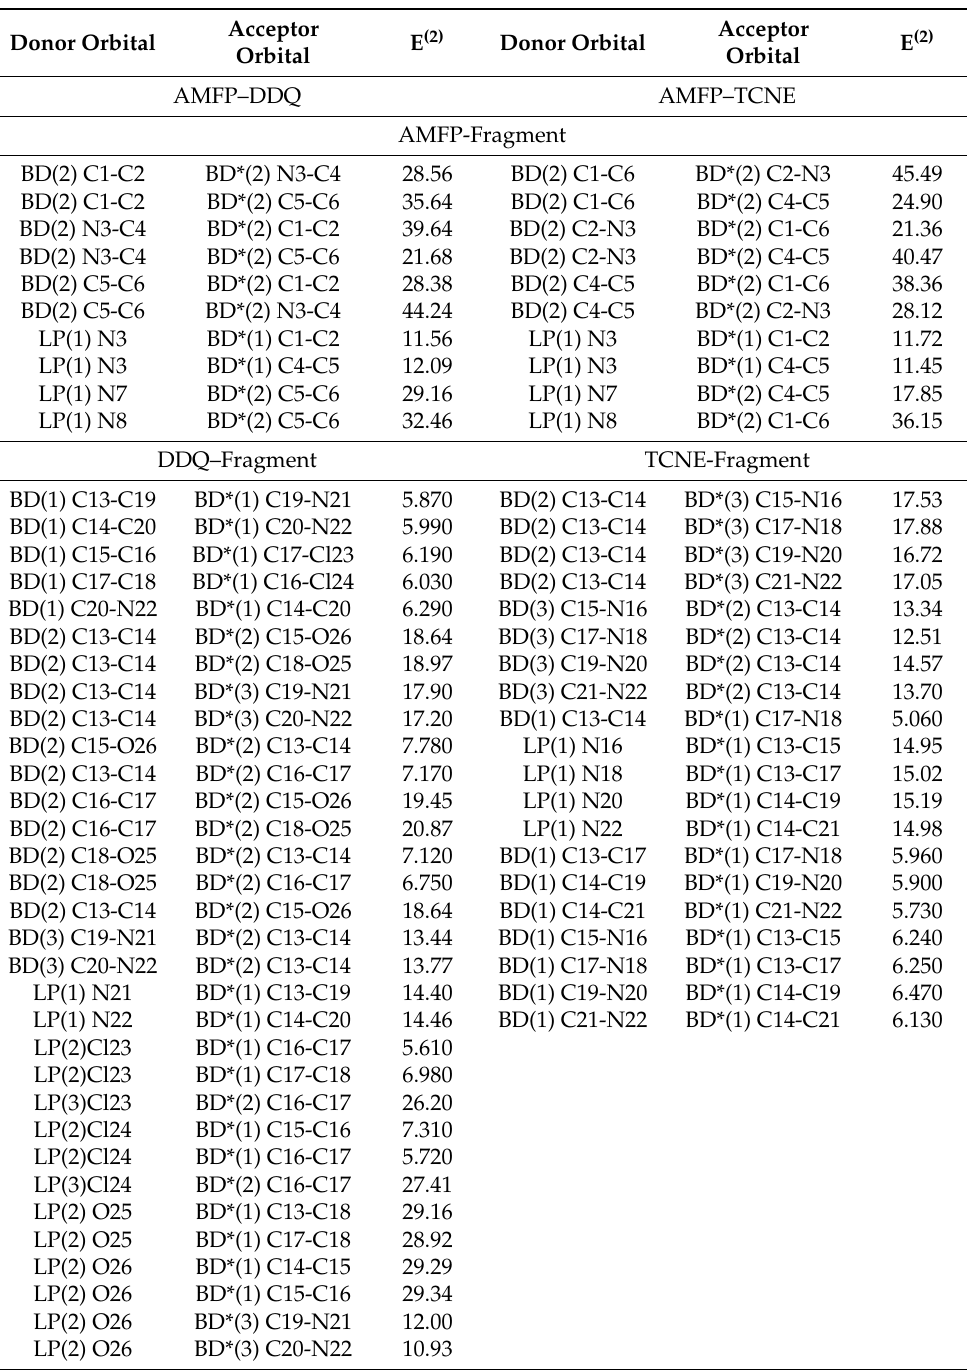
Table 8. Stabilization energies of donor-acceptor interactions in the AMFP–DDQ and AMFP–TCNE